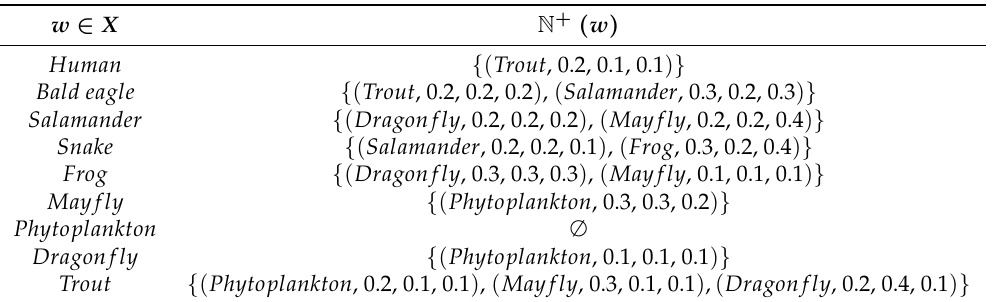
Figure 17. IN-food web. Table 8.